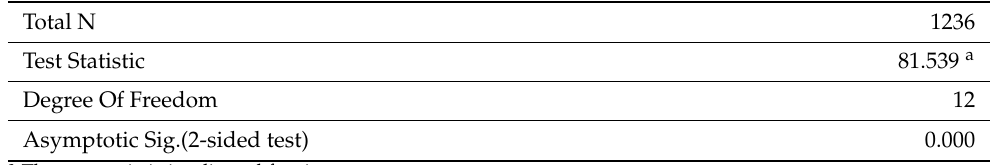
Table 3. Independent-Samples Kruskal–Wallis H Test Summary. The table shows